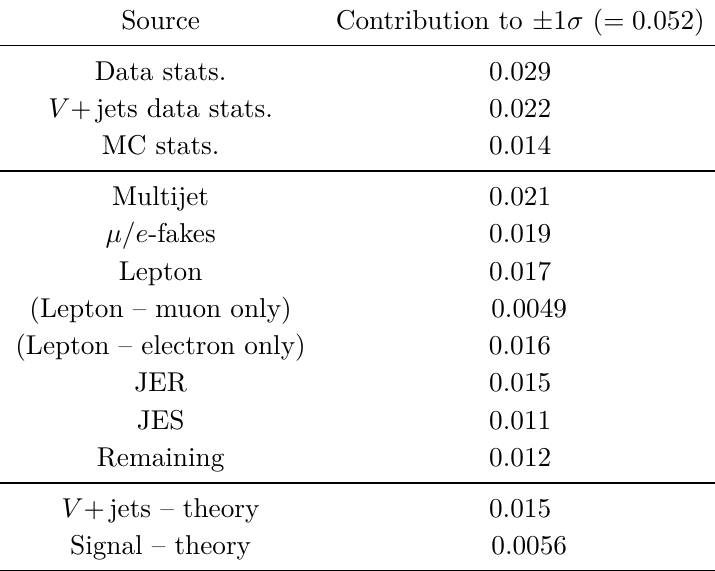
Table 8. The contributions to the 68% confidence interval of the fitted signal strength µ from different sources of systematic uncertainty. They are evaluated in a fit with the data yields set to the total background expectation. Due to residual correlations between categories, the sum in quadrature of the individual contributions only approximately equals the total uncertainty. The uncertainty due to the number of data events (‘Data stats.’) is obtained by fixing all systematic uncertainties to their best-fit values. The entry ‘ V + jets data stats.’ is the statistical uncertainty originating from data yields for the W and Z normalisation. The experimental uncertainties and the uncertainty related to the size of MC simulated samples (‘MC stats.’) are treated as separate categories. The ‘Remaining’ category contains E miss , luminosity, and pile-up uncertainties, and a T diboson uncertainty in the Z CR. ‘‘